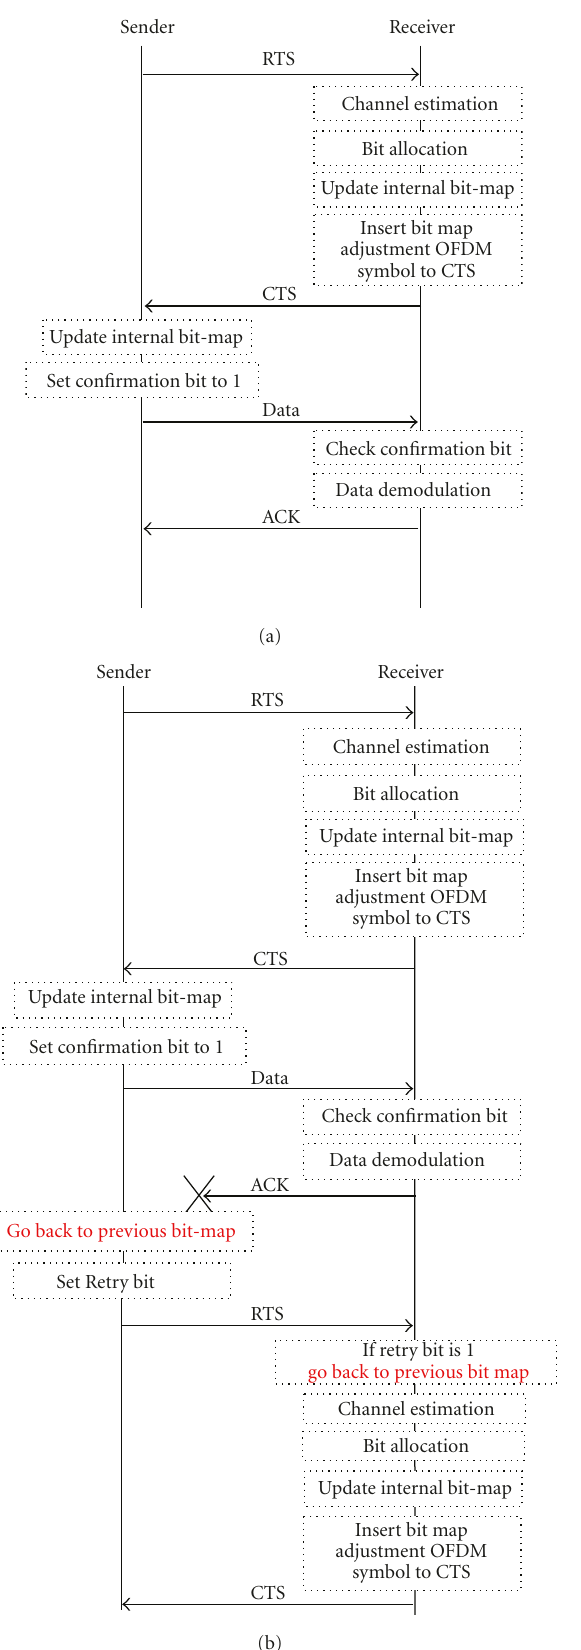
Figure 6: Protocol operation in cases of (a) successful transmission and (b) ACK loss.